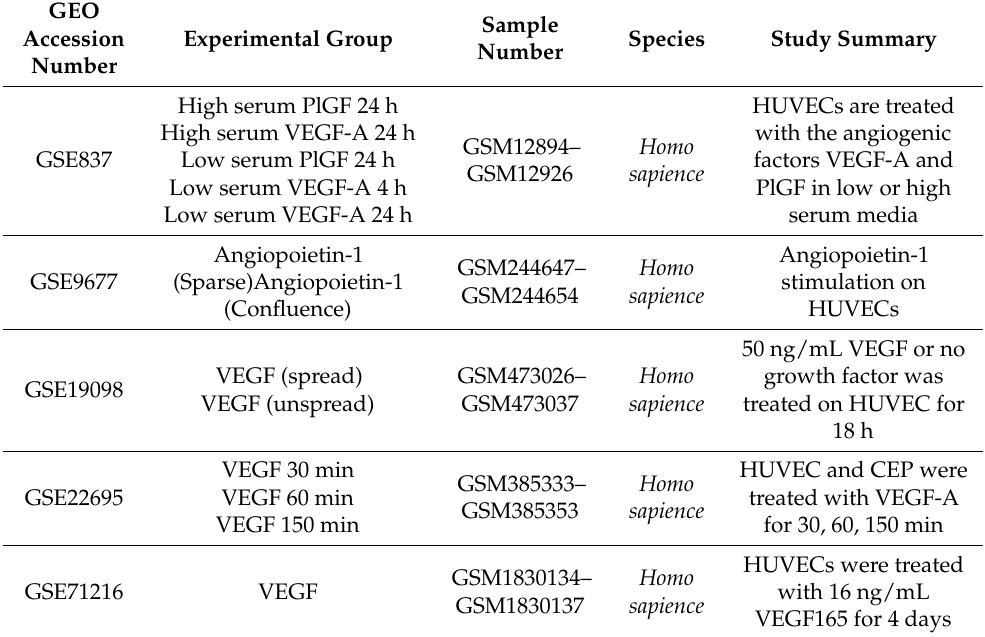
Table 1. List of GEO datasets used in this study.